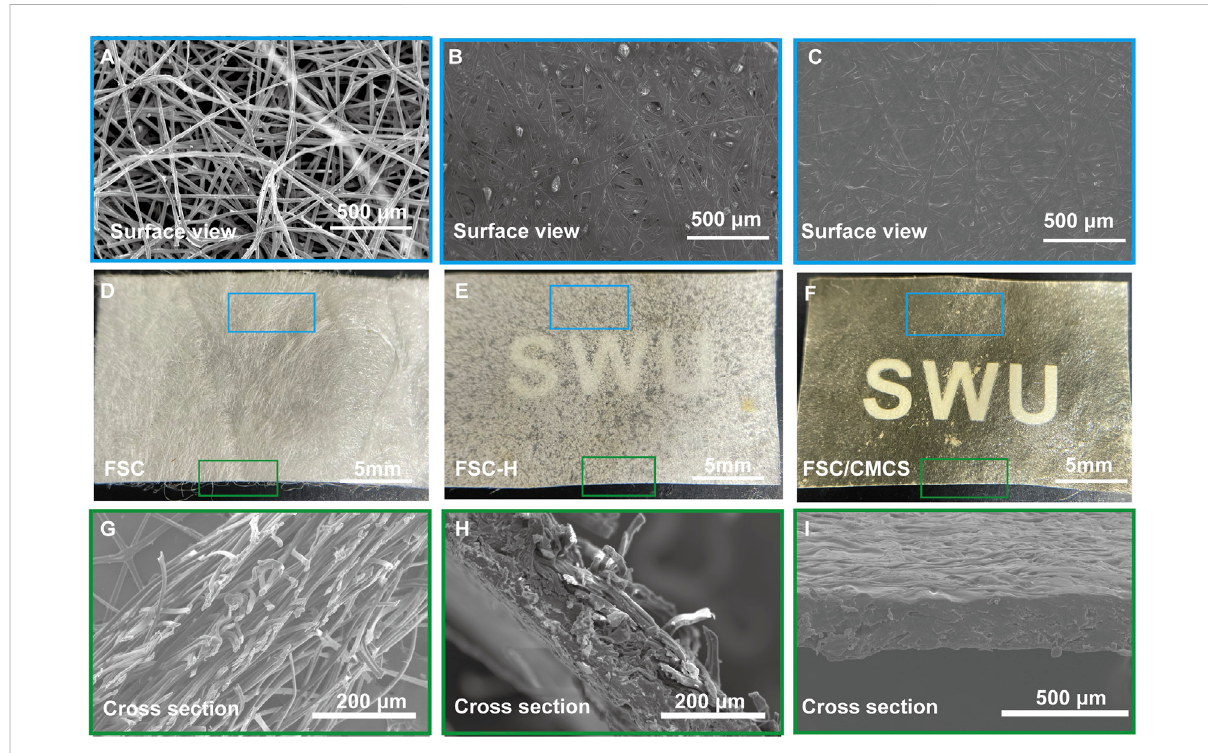
FIGURE 2 Digital and SEM images of the structures and morphologies. (A – C) Corresponding microstructure from the surface view. (D – F) Macroscopic presentations of FSC, FSC-H, and FSC/CMCS membranes. (G – I) Corresponding microstructure from a cross-sectional